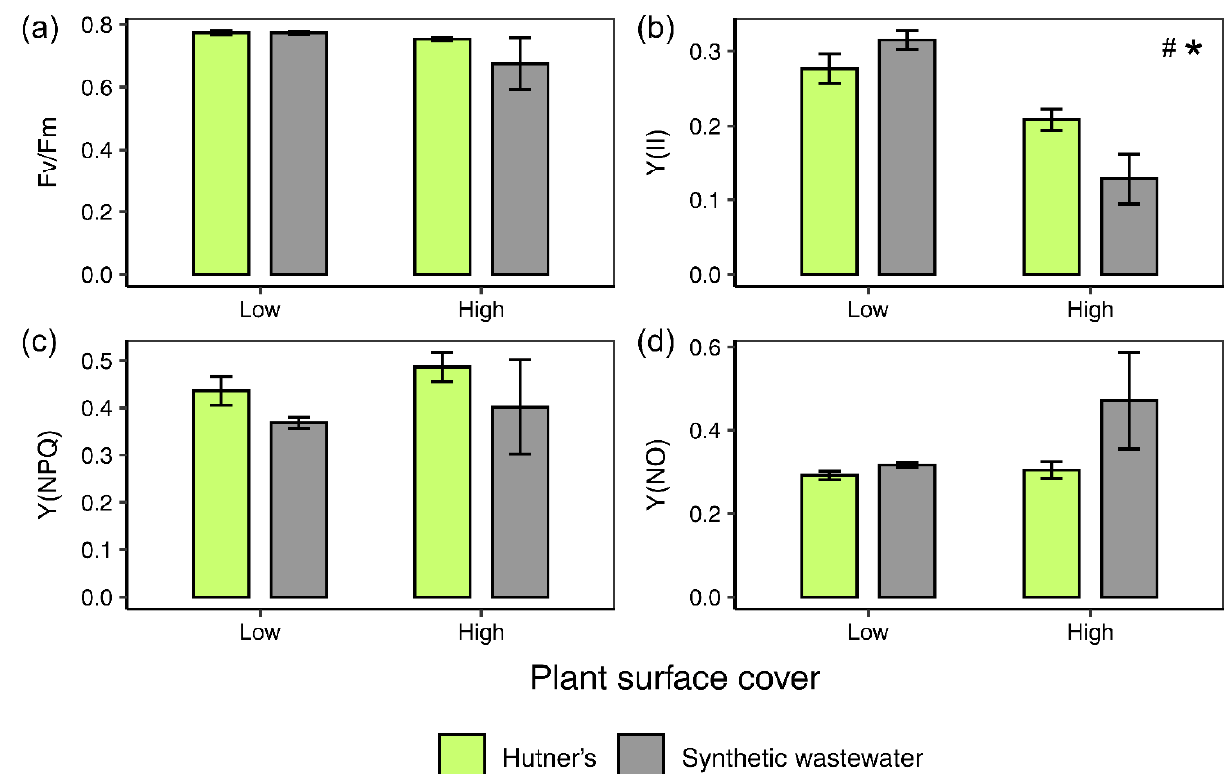
Figure 4. Mean ( ± SE) ( a ) F v /F m , ( b ) Y(II), ( c ) Y(NPQ) and ( d ) Y(NO), for L. minor grown on either synthetic wastewater or half-strength Hutner’s medium at two plant surface covers (low, 25% and high, 60%) over 7 days. A hash symbol (#) denotes an effect of density for p < 0.05, and a star symbol (*) denotes an interactive effect between density and medium for p < 0.05, as per the two-way ANOVA.